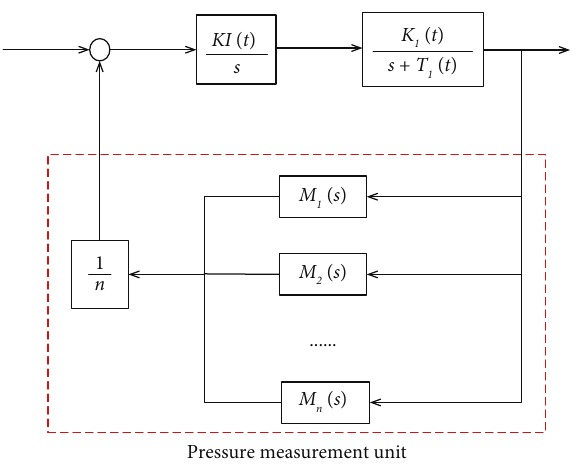
Figure 3: Multisensor redundant closed-loop control system for GG ’ s